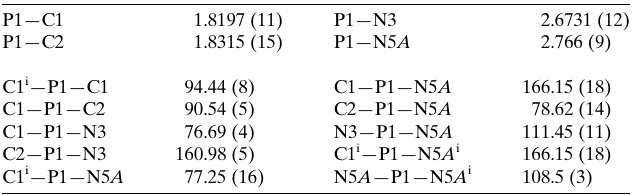
Table 2 Selected geometric parameters (A˚ , (cid:2) ) for 2 .